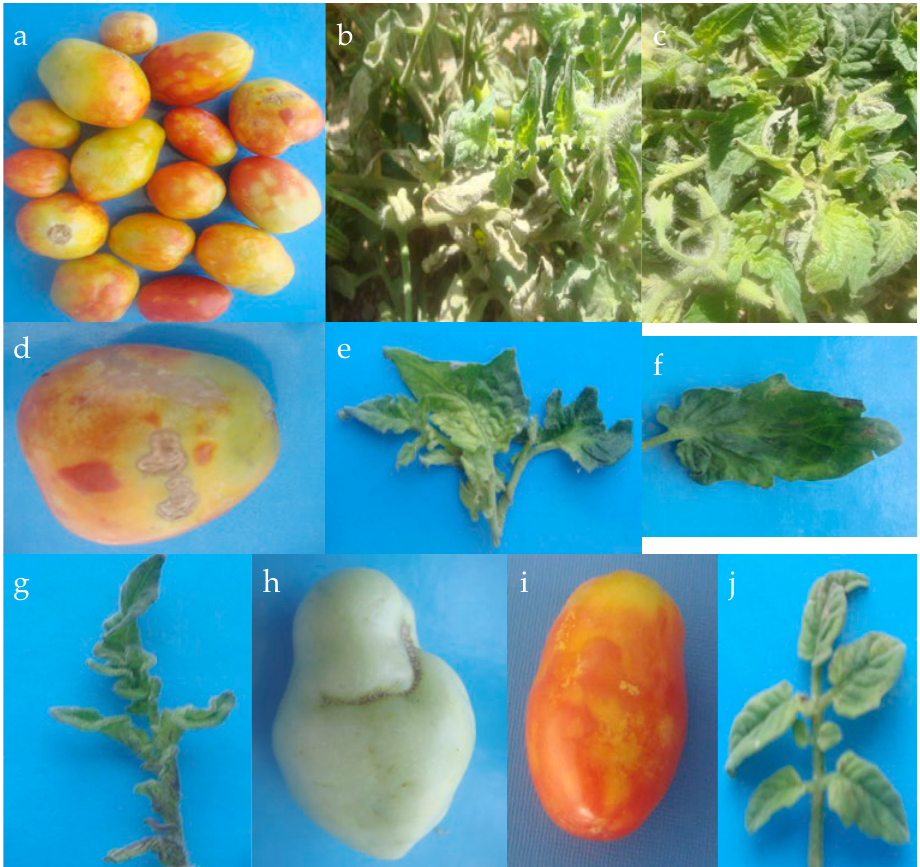
Figure 1. Symptoms of collected samples: (a), (b) and (c) tomato fruits and leaves with symptoms suggestive of virus infec- tion; (d), (e) and (f) TMV infected fruit and leaves; (g) and (h) CMV infected leaf and fruit; (i) and (j) TSWV infected fruit and leaf. TMV = Tobacco mosaic virus; CMV = Cucumber mosaic virus and TSWV = Tomato spotted wilt